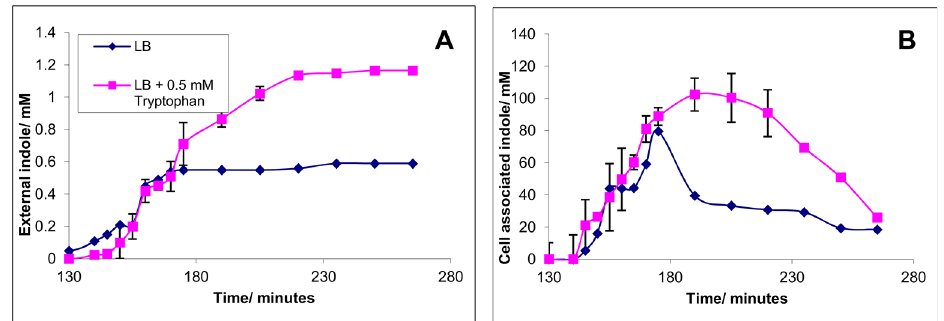
Fig 4. The effect of tryptophan supplementation on the indole pulse during stationary phase entry. A culture of growing BW25113 in LB medium with 0 or 0.5 mM tryptophan added was sampled regularly. The supernatant was assayed for external indole using Kovacs assay (panel A) and the cell pellet was assayed for indole using Kovacs assay (panel B). Data shown are the mean values ± standard deviation for three independent